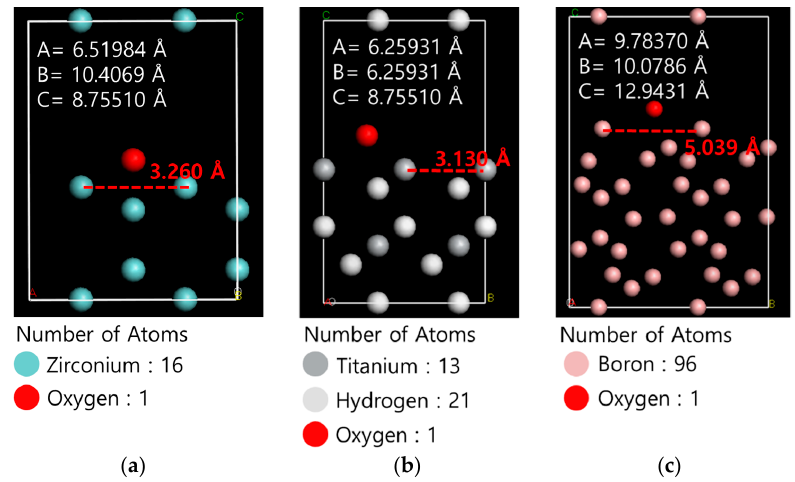
Figure 4. Constructed vacuum slab systems (side view) and their dimensions for Zr ( a ), TiH 2 ( b ), and B ( c ).